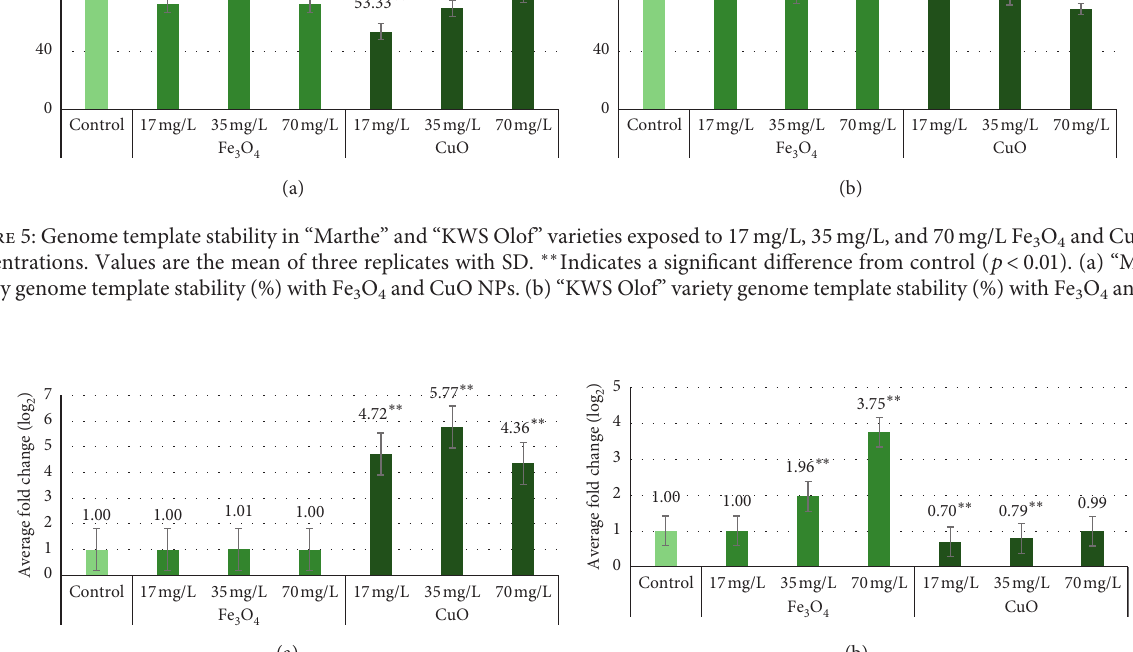
3 O 4 and CuO NPs.